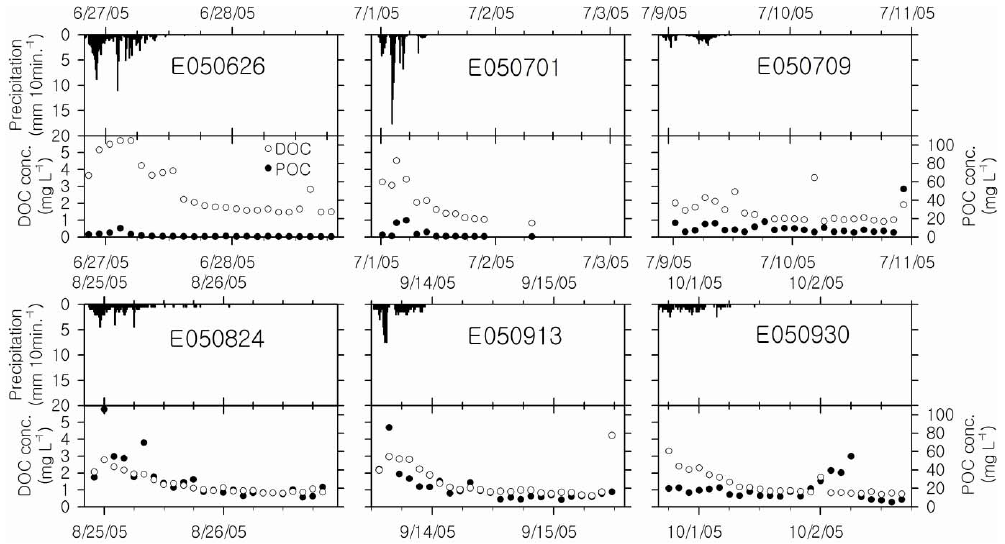
Fig. 3. Precipitation and temporal variations of DOC and POC concentration in streamwater during the six storm events from June to October 2005. Table 5. The relative contribution and uncertainty (%) of Hills- lope Runoff (HR), Hillslope Groundwater (HGW), and Riparian Groundwater (RGW) for the six storm events from June to Octo- ber 2005. Absolute errors of the analytical precision were included through the hydrograph separation equations based on the proce- dure outlined by Genereux